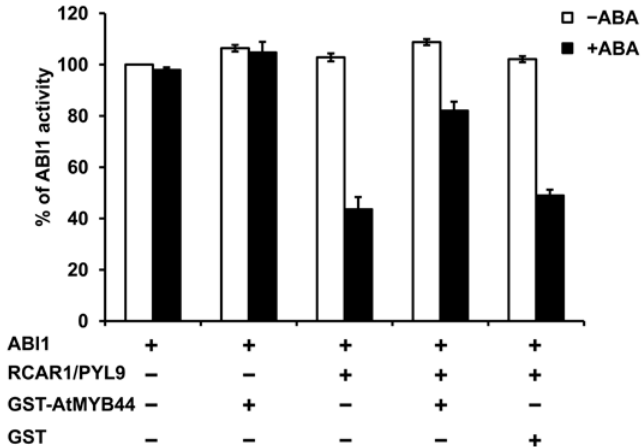
Figure 5. AtMYB44 reduces the inhibitory effect of RCAR1/PYL9 on ABI1 phosphatase activity in vitro. ABI1 phosphatase activity was determined using p-nitrophenyl phosphate (pNPP) as the substrate in the absence (open bars) or presence (filled bars) of 10 μM ABA. The concentrations of each protein component were 0.5 μM for ABI1, 5 μM for RCAR1/PYL9, and 10 μM for GST-AtMYB44 or GST. The relative phosphatase activity of each reaction was normalized against the reaction containing substrate and ABI1 (100%). Data are means ± SD from three independent